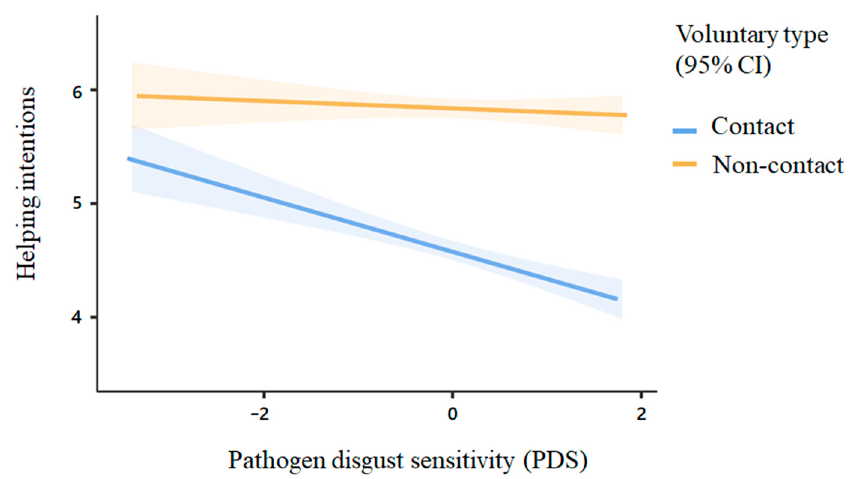
Figure 1. The effect of PDS on helping intentions toward different types of voluntary work. Note. Shadows represent 95% confidence intervals (i.e., 95% CI).